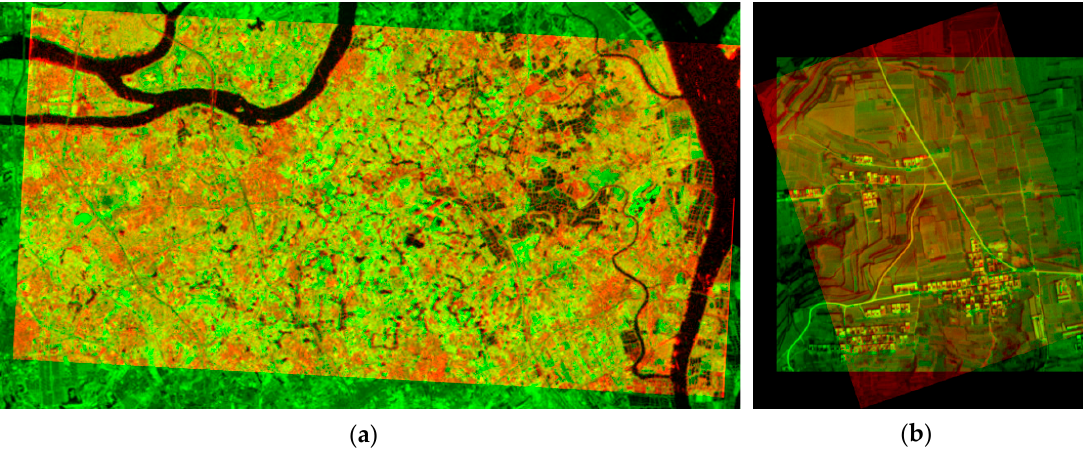
Figure 6. Manually registered images using ERDAS AutoSync. ( a ) The green component and red component are the reference image and the warped sensed image of the No. 1 image pairs, respectively; ( b ) the green component and red component are the reference image and the warped sensed image of the No. 4 image pairs, respectively.